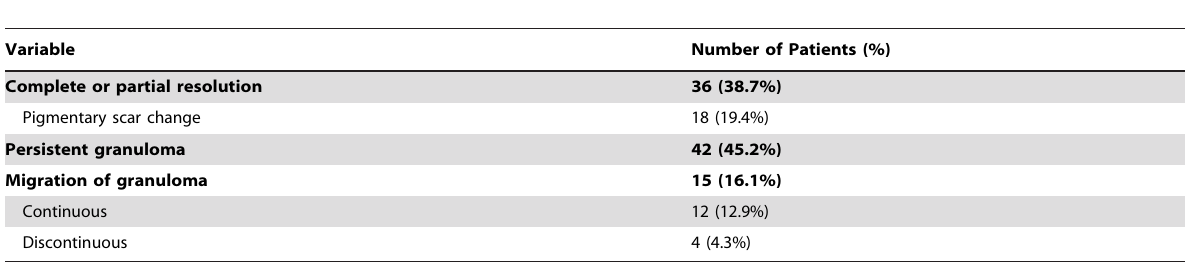
Table 3. Clinical course of granuloma in adult patients with ocular